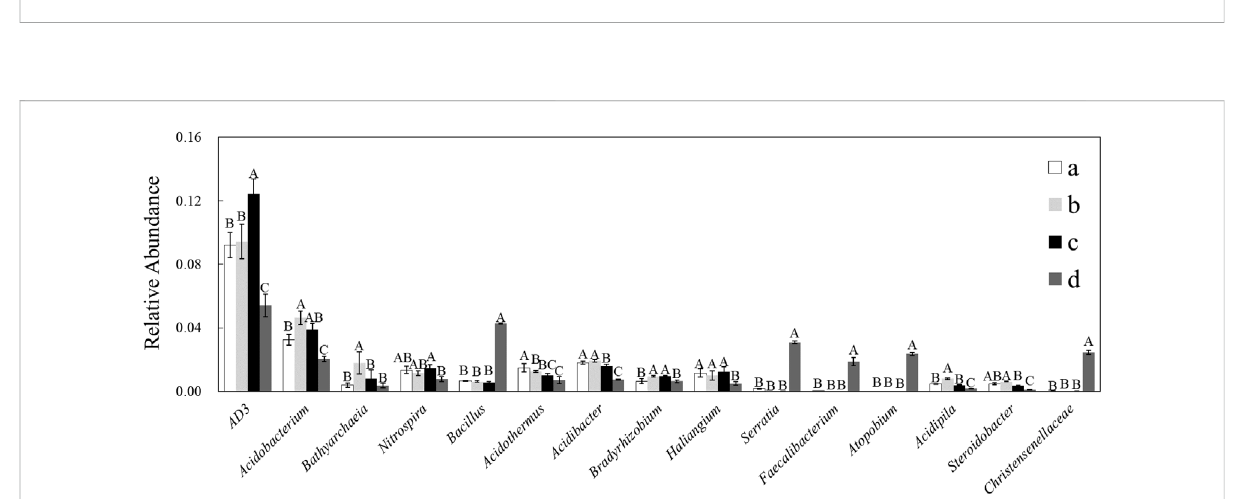
FIGURE 6 Bacterial genera with high relative abundance and signi fi cance. Different uppercase letters above bars within the same genus indicate signi fi cant differences among treatments (p < .05). (A) litchi orchard with no intercropping; (B) litchi orchard intercropped with Desmodium ovalifolium ; (C) litchi orchard intercropped with Grona heterocarpos ; (D) litchi orchard intercropped with Stylosanthes guianensis